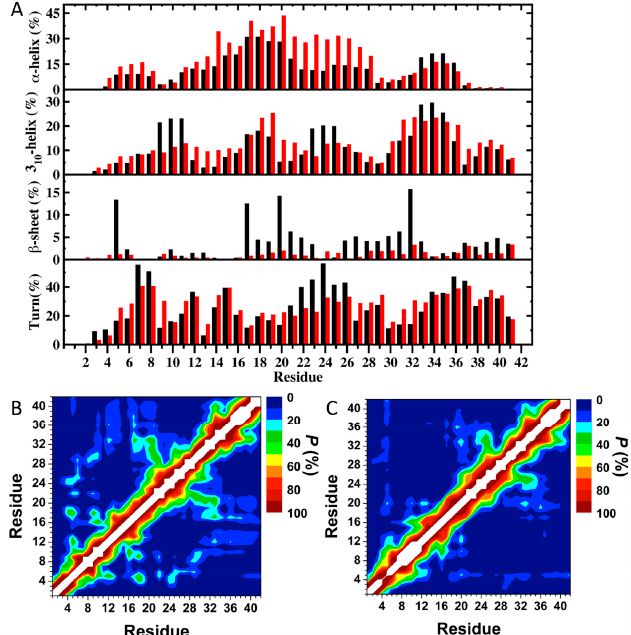
Figure 4. ( A ) Secondary structure components per residue along with their abundances per residue for WT A β 42 (black) and the Tyr10Ala mutant (red) in an aqueous solution. The abundances of the π -helix and coil conformations are not displayed; ( B ) Tertiary intramolecular interactions and abundance of tertiary contacts in the structure of WT A β 42 ; ( C ) Tertiary intramolecular interactions and abundance of tertiary contacts in the structure of the Tyr10Ala mutant. In last two plots, the color scale corresponds to the probability (P) that the distance between the centers of mass of two residues is ≤ 9 Å. Int. J. Mol. Sci. 2018 , 19 , x FOR PEER REVIEW